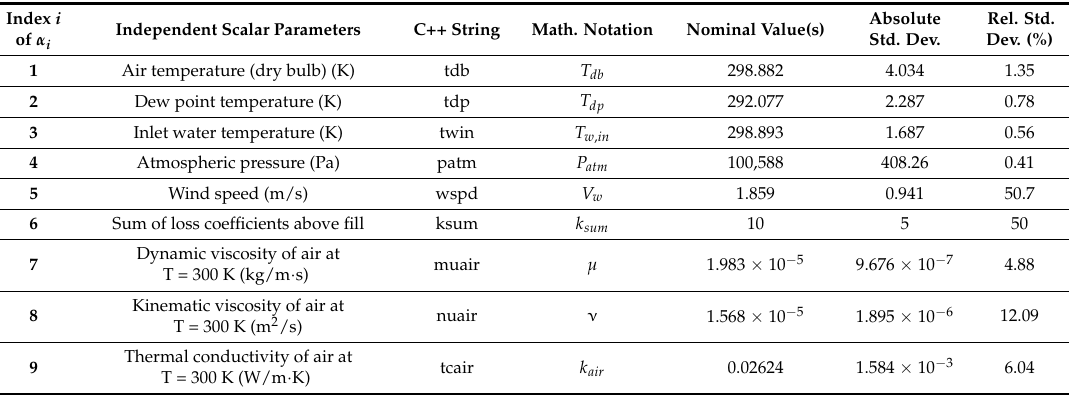
Table B1. Parameters for SRNL F-area cooling